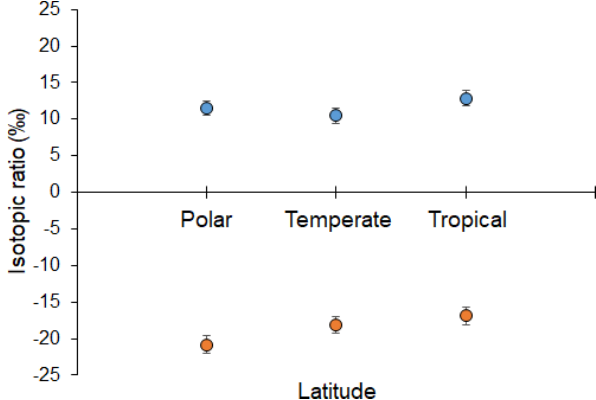
Figure 2. Stable N and C isotopic composition of deep-sea animals across latitudes. Mean values of δ 15 N (blue circles above) and δ 13 C (orange circles below) (‰) measured in deep-sea organisms across polar, temperate, and tropical latitudes. Bars represent standard de- viation (polar, n = 235; temperate, n = 1469; tropical, n = 41).